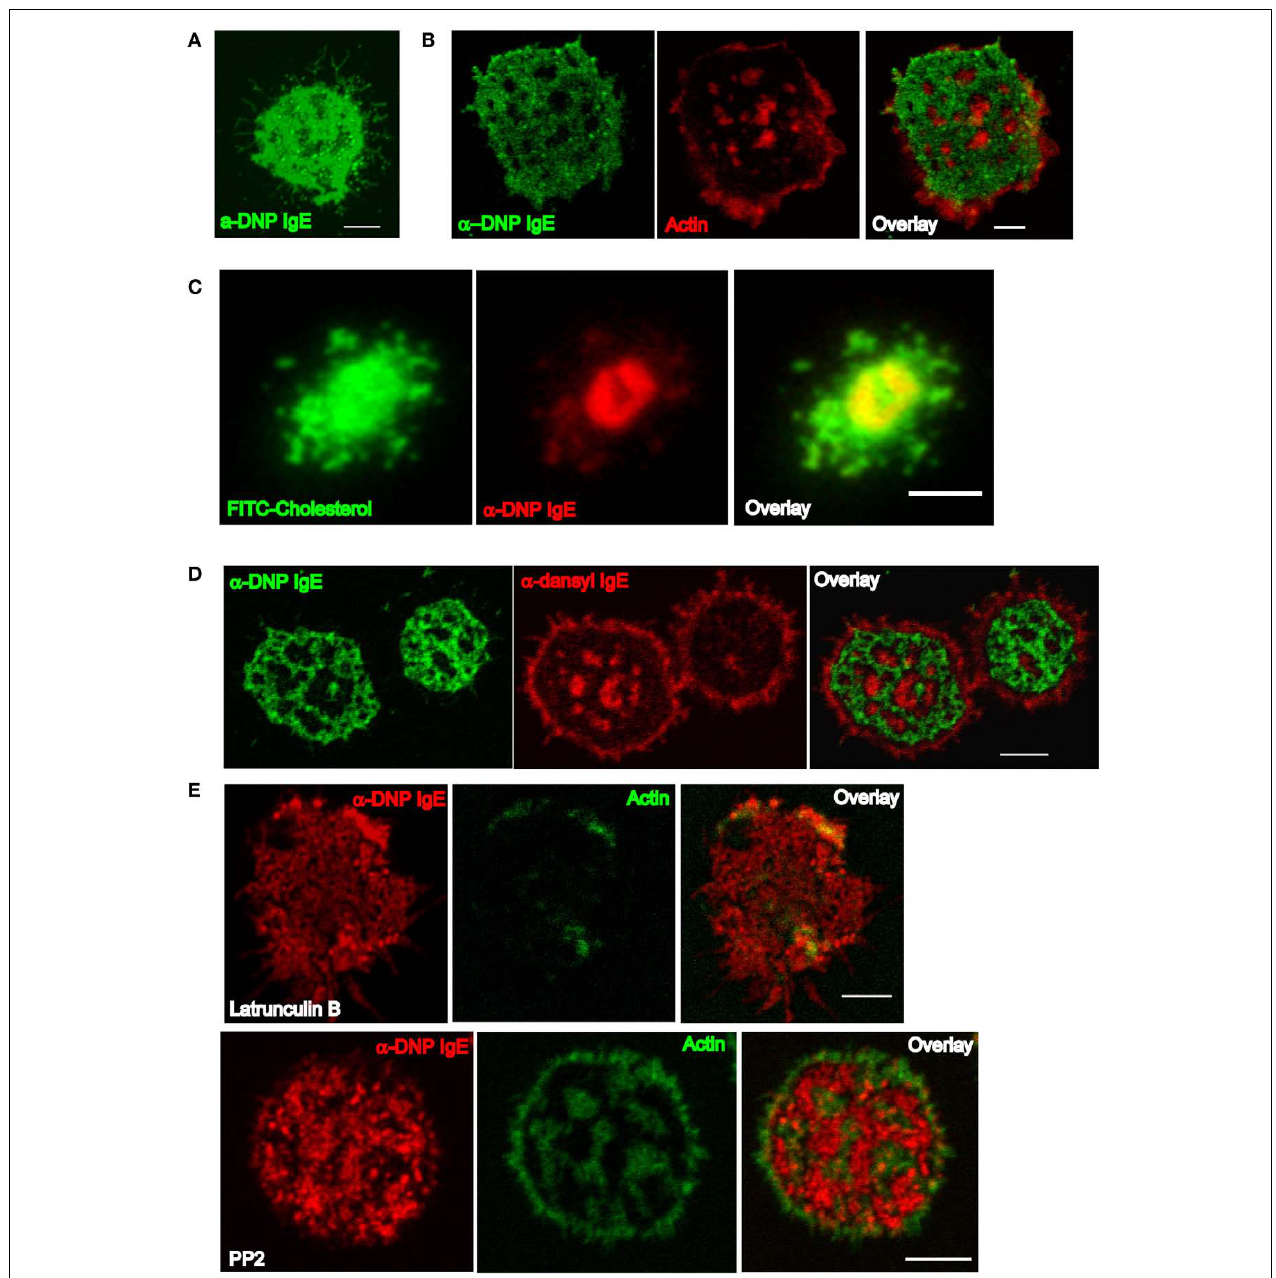
IgE A555 after 20min on a 25mol% DNP-lipid bilayer. (D) Confocal section of RBLs co-primed with equal concentrations of α -DNP IgE A488 and α -dansyl IgE A555 and settled onto 25mol% DNP-lipid bilayers after 20min. (E) Confocal sections of RBLs primed with α -DNP IgE A555 and pretreated with either Latrunculin B (upper row) or PP2 (lower row) settled on 25mol% DNP-lipid bilayers for 20min. Cells were paraformaldehyde fixed and stained with A488 phalloidin. All images have been brightness and contrast enhanced. Scale bars are 5 μ